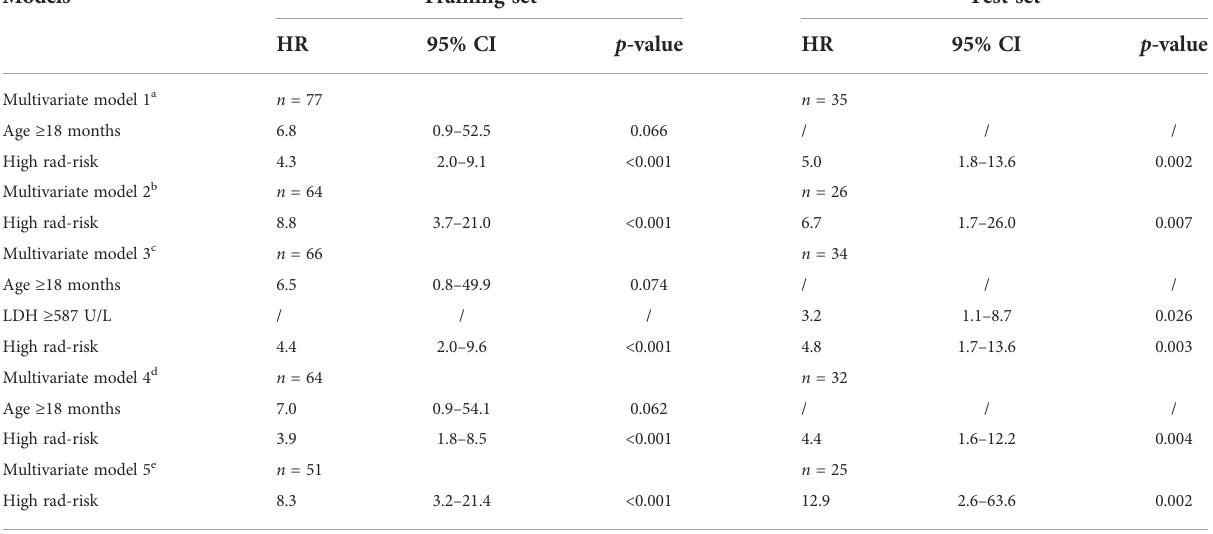
TABLE 3 Multivariate Cox regression analyses for event-free survival. Models Training